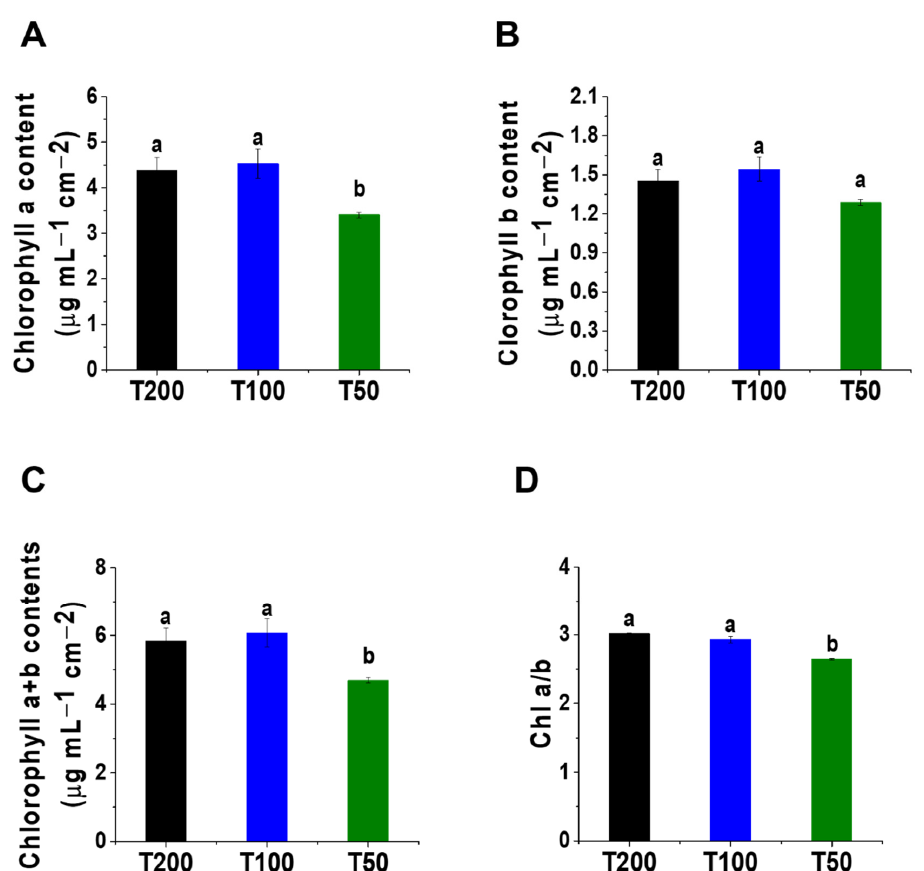
Figure 3. Effect of different light intensities on chlorophyll a content ( A ), chlorophyll b content ( B ), chlorophyll a + b content ( C ), and chlorophyll a/b (ratio) ( D ). The error bar on each mean value column is ± SE. Lowercase letters on each column present significant differences using the LSD test at p < 0.05. T200 denotes 200 μ mol m − 2 s − 1 of light intensity; T100 denotes 100 μ mol m − 2 s − 1 light intensity; and T50 denotes 50 μ mol m − 2 s − 1 of light intensity.